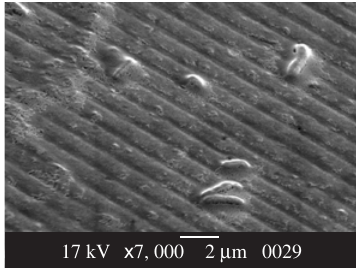
Figure 4. SEM microphotograph of Cu nanoestructured surface exposed during 30 minutes to P. fluorescens culture.